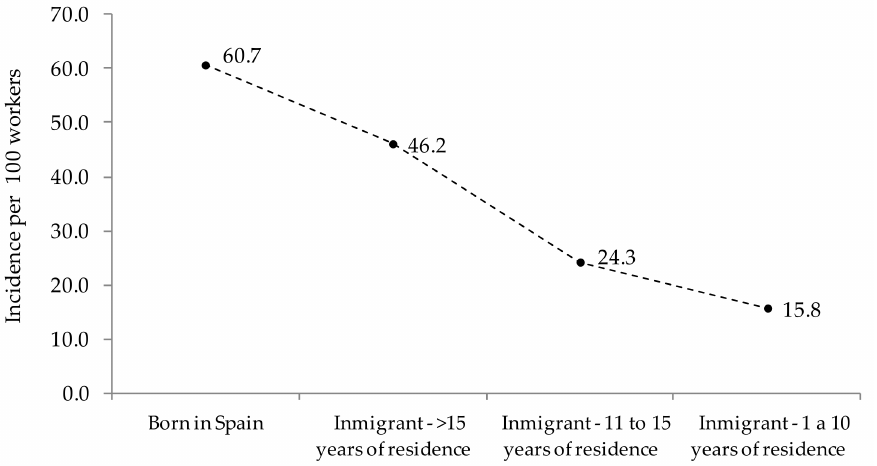
Figure 1. Incidence of common mental disorders by migration status and time of residence in Spain.